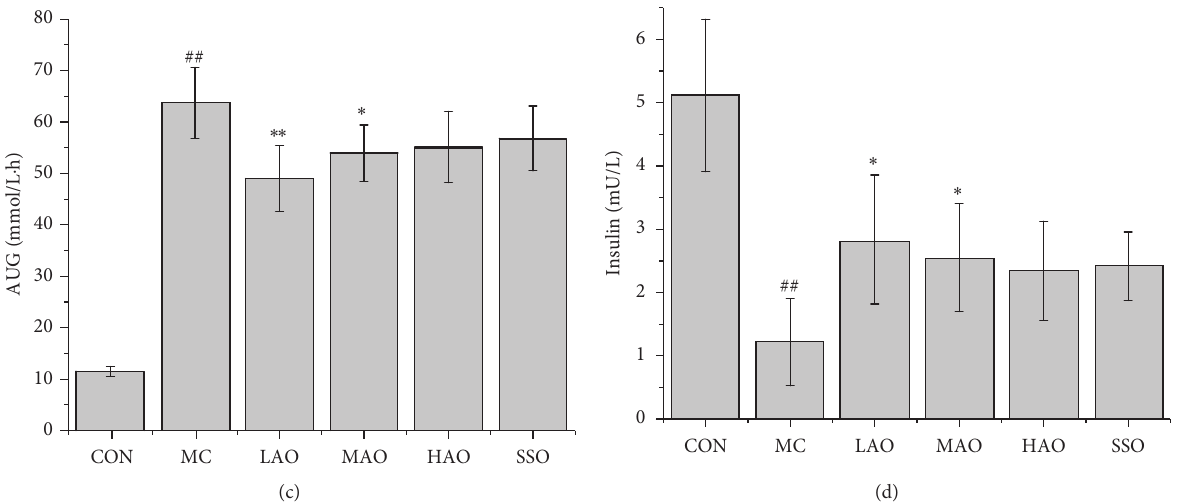
Figure 2: Effects of almond oil on the FBG, glucose tolerance, and insulin levels in STZ-induced rats. (a) Fasting blood glucose. (b) Glucose tolerance. (c) Area under the curve of blood glucose (AUC). (d) Serum insulin. Data were expressed as means ± SD. The MC group compared with the CON group, # P < 0 . 01, ## P < 0 . 01; the LAO, MAO, HAO, and SSO groups compared with the MC group, ∗ P < 0 . 05, ∗∗ P < 0 . 01.